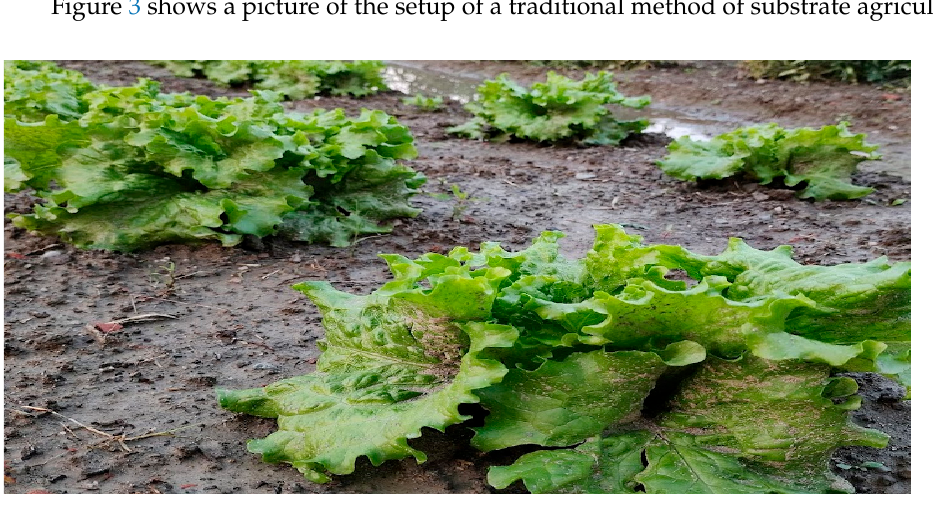
Figure 3. Romaine lettuce was grown in a substrate medium.